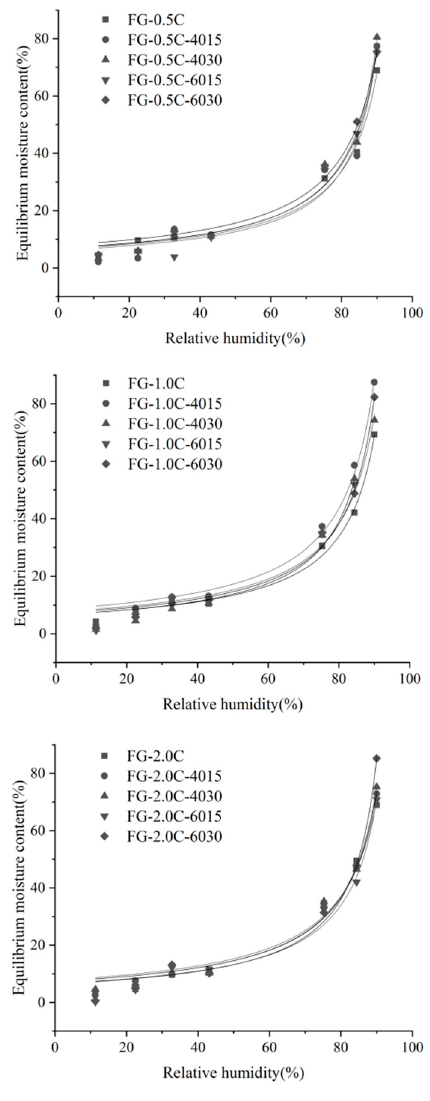
Figure 1. Fitting curves of isothermal hygroscopic Guggenheim–Anderson–de Boer (GAB) model of flaxseed gum (FG)-carvacrol (C) films with ultrasonic assisted treatment. Table 3. Guggenheim–Anderson–de Boer (GAB) isothermal moisture absorption model parameters and fitting accuracy of flaxseed gum films incorporated with